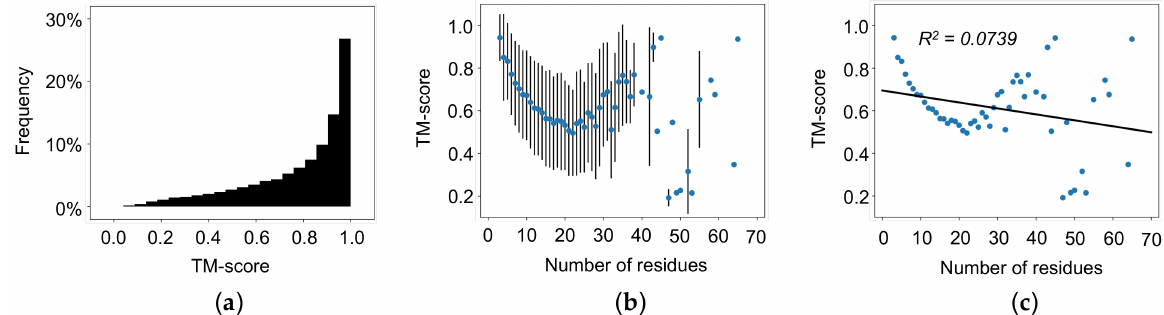
Figure 3. TM-score of AlphaFold 2 predicted structures with the equivalent experimentally deter- mined structure as a template. ( a ) TM-scores of all loop regions. ( b ) Averaged TM-score as a function of the number of residues in a loop with standard error bars. ( c ) Averaged TM-score as a function of the number of residues in a loop with linear regression (R 2 = 0.0739). TM-score increases as the number of residues in the loop regions increases. Table 1. Fraction of DSSP secondary structure types in experimentally determined and AlphaFold 2 predicted structures. AlphaFold 2 predicted secondary structure content (parallel beta